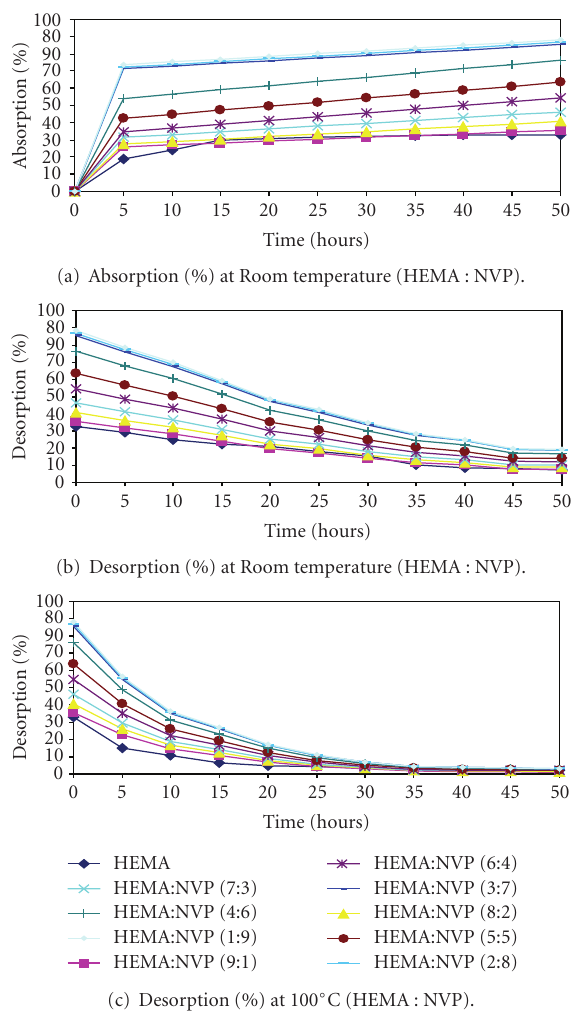
Figure 6: Studies on water absorption and desorption of polymers obtained with HEMA : NVP.